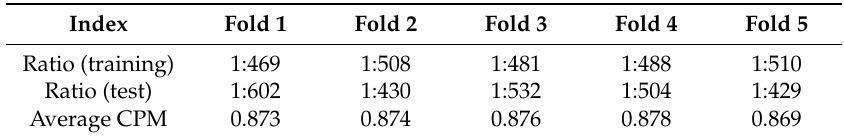
Table 7. CPM scores for each round of five-fold cross-validation on the V1 dataset. The ratio represents the ratio of nodule to non-nodule in the training / test